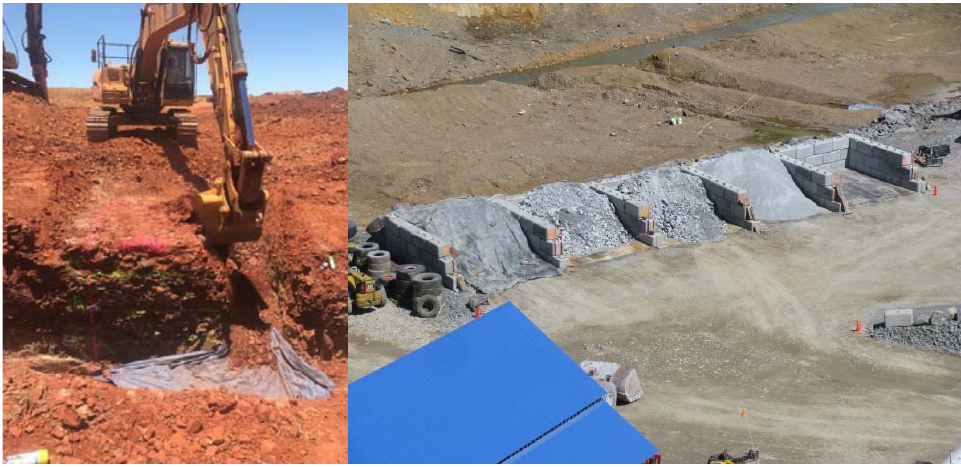
Figure 8. The collection of surface ( Left ) or underground bulk samples must be undertaken with care to ensure full sample extraction, transport and storage ( Right ) prior to processing.